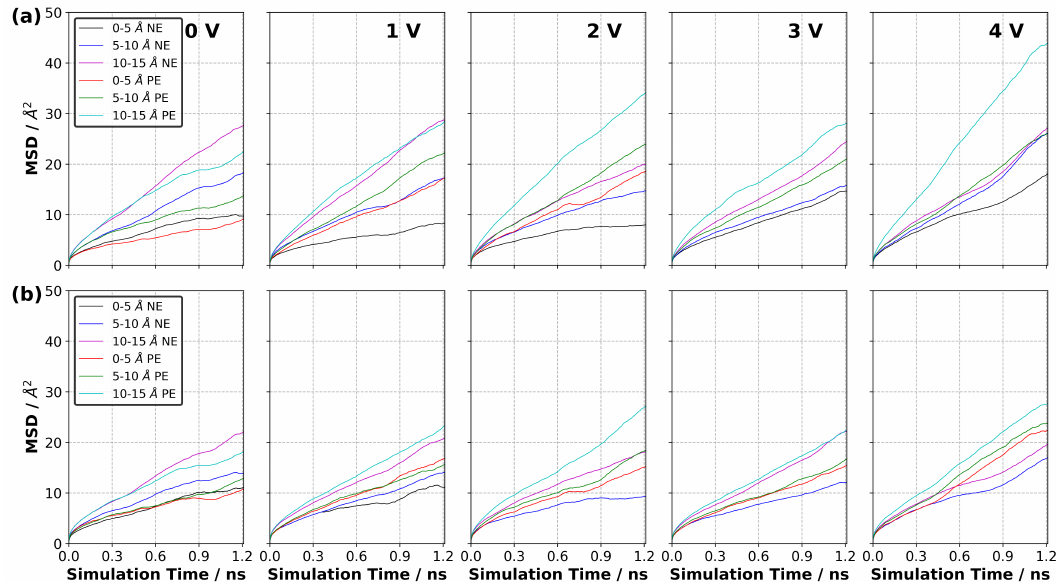
Figure 18. Calculated mean square displacement (MSD) in the first layer (0–5 Å), second layer (5–10 Å) and third layer (10–15 Å) from the electrode surface at each ∆Ψ for ( a ) [C 2 mim] + and ( b ) [NTf 2 ] − in the [C 2 mim][NTf 2 ] system at 294 K. NE and PE stand for negative electrode and positive electrode, respectively (averaged over three independently generated